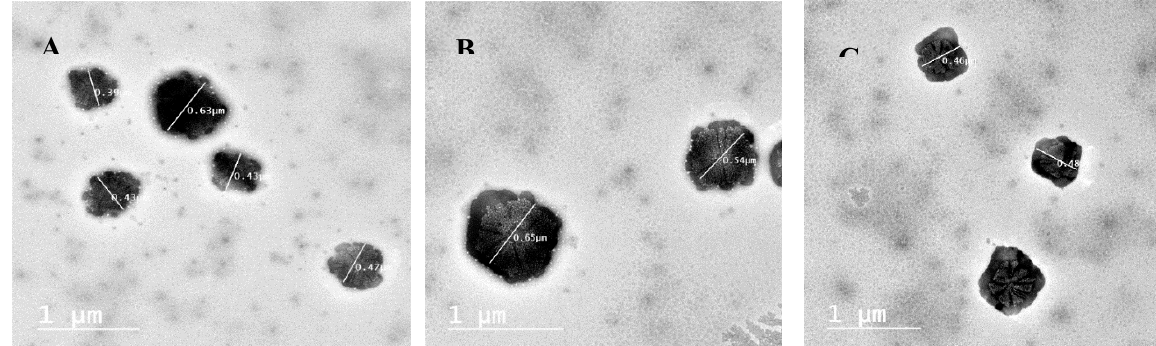
Figure 5. TEM micrographs of ( A ) BA-loaded-LA-free-CL-NPs; ( B ) BA-loaded-LA-modified-CL-NPs and ( C ) BA-loaded-LA-modified-CL-NPs after sonication.